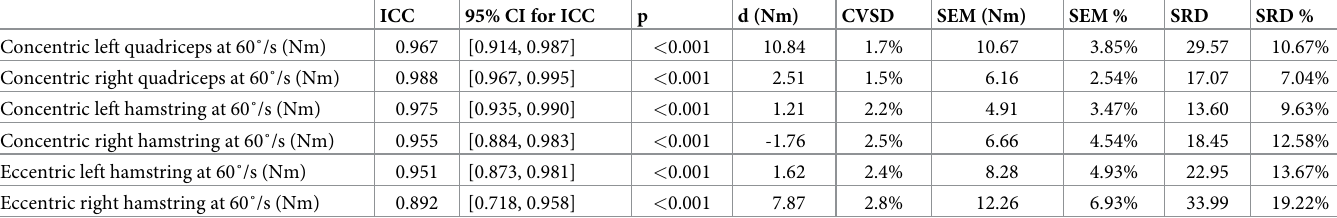
Table 2. Reproducibility measures of the isokinetic concentric and eccentric knee flexion and extension. ICC 95% CI for ICC Concentric left quadriceps at 60˚/s (Nm) Concentric left hamstring at 60˚/s